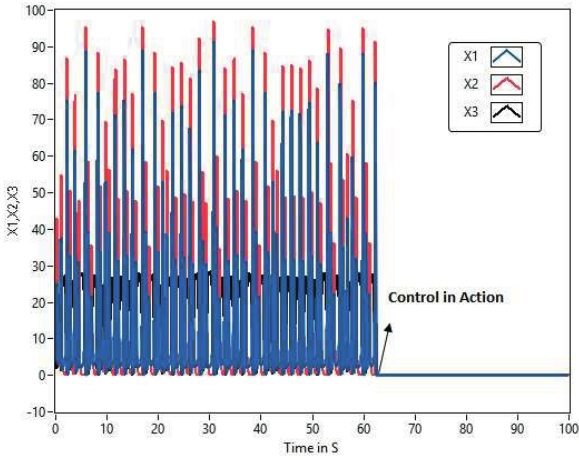
Fig. 3: Sliding Mode Controller in action ( t = 62 s).